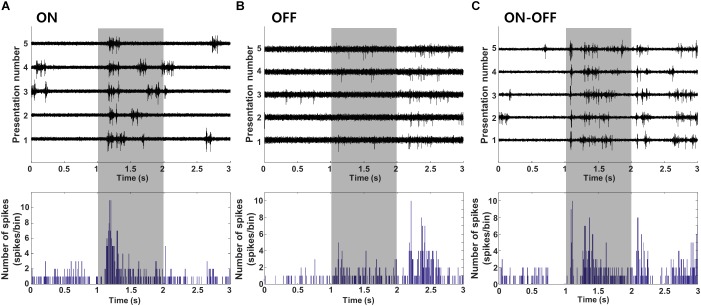
Cell type classification based on visual response. (A–C) Cell were classified into ON, OFF, or ON-OFF types based on the polarity of their response to a full-field light stimulus (duration of 1 s indicated by the shaded box). Light stimulation was applied 30 times; raw waveforms for 5 consecutive presentations (out of 30) are shown for a typical cell of each type. PSTHs for all cell types are shown at bottom (time bin = 10 ms).